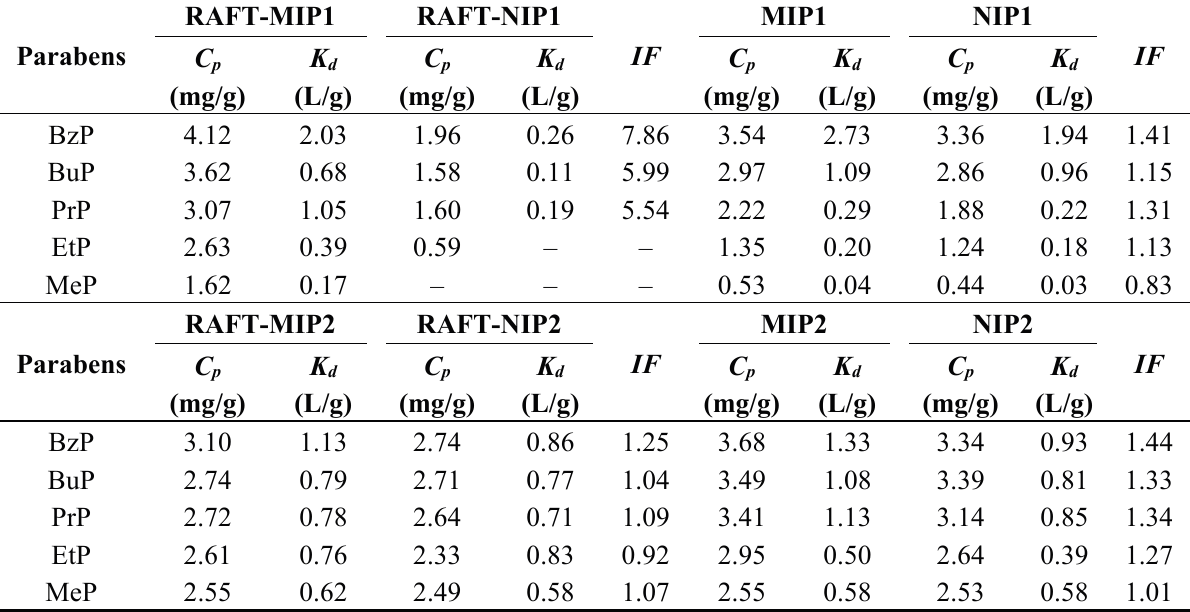
Table 3. C p (mg/g), K d (L/g) and IF values of the parabens on polymers.